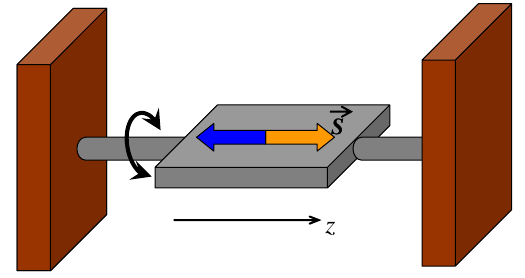
FIG. 1. System studied in the paper. Macrospin (e.g., a mag- netic molecule) is attached to a torsional oscillator such that the magnetic anisotropy (quantization) axis is parallel to the axis of mechanical